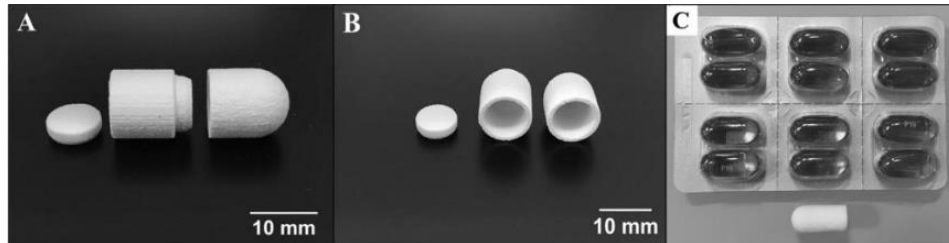
Figure 11. Multi-compartment preform tablet. ( A ) Side view of the three pieces constituting the pre- form tablet. From left to right, top cap, top compartment, and bottom compartment. These pieces were manufactured by powder-bed 3D printing using binder DI water with 5% ethanol and 0.25% Tween 80. The powder utilized for their construction was calcium sulfate. Each of the two wells has a 250 µL capacity. ( B ) Front view of the preform tablet fabricated. ( C ) Comparison between the assembled version of the preform tablet and commercially available gel capsules [74].